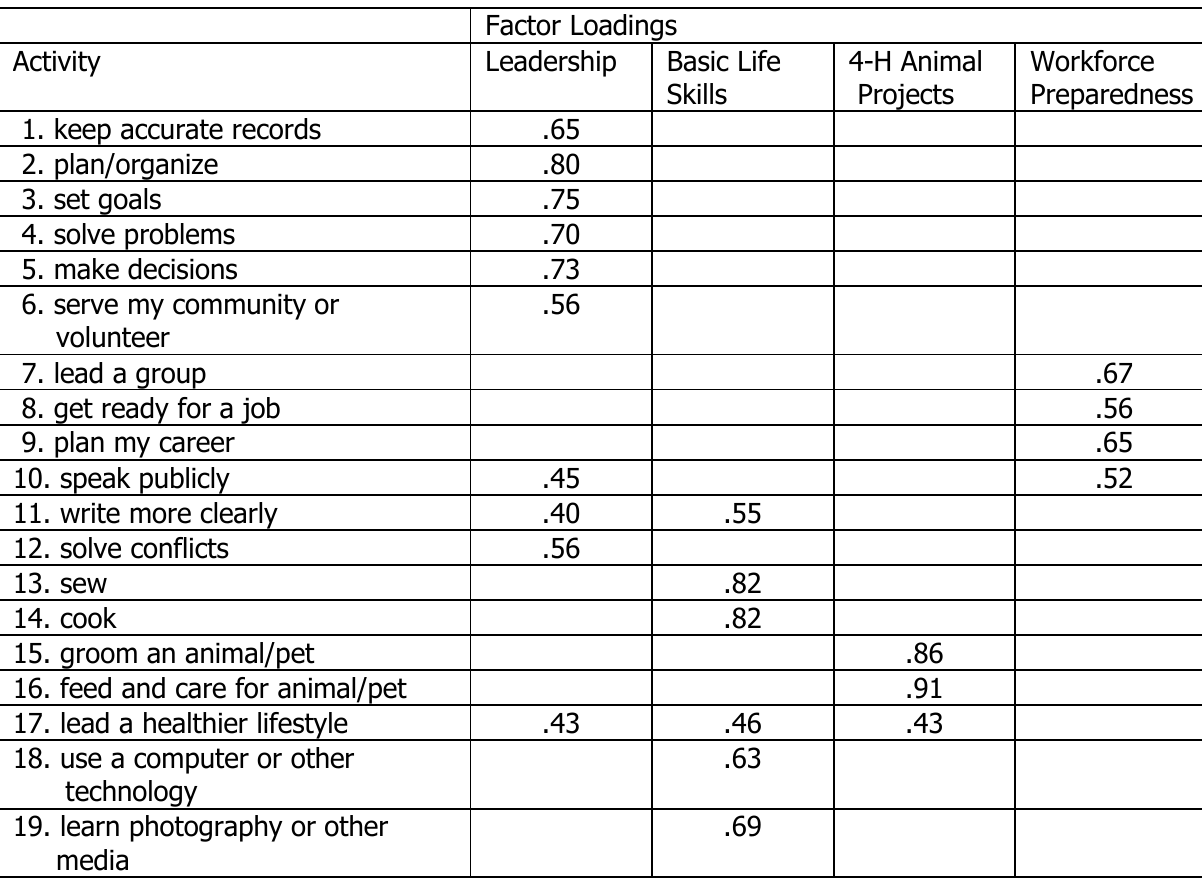
Summary of factor loadings for orthogonal four-factor solution for